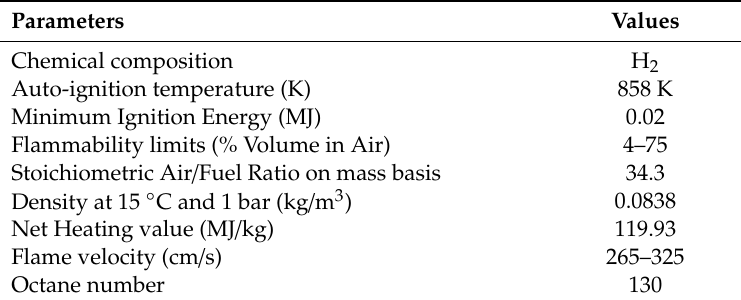
Table 2. Properties of